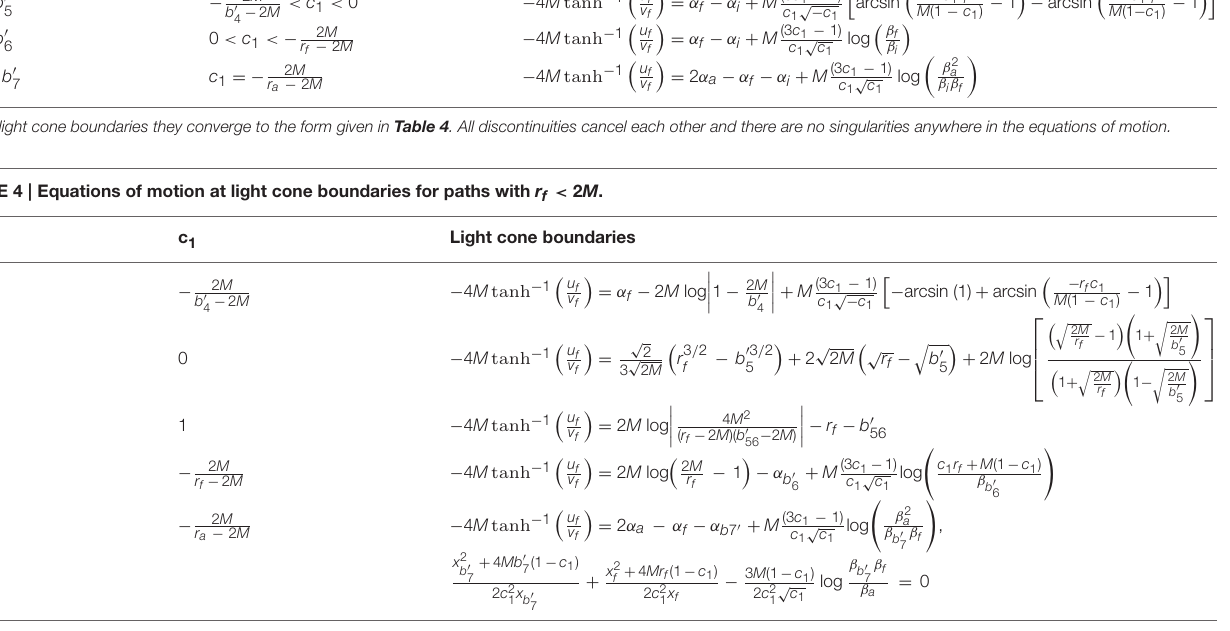
TABLE 3 | The equation of motion with r f < 2 M . Range of r i c 1 Equations of motion for paths with r i > 2 M and r f < 2 M .